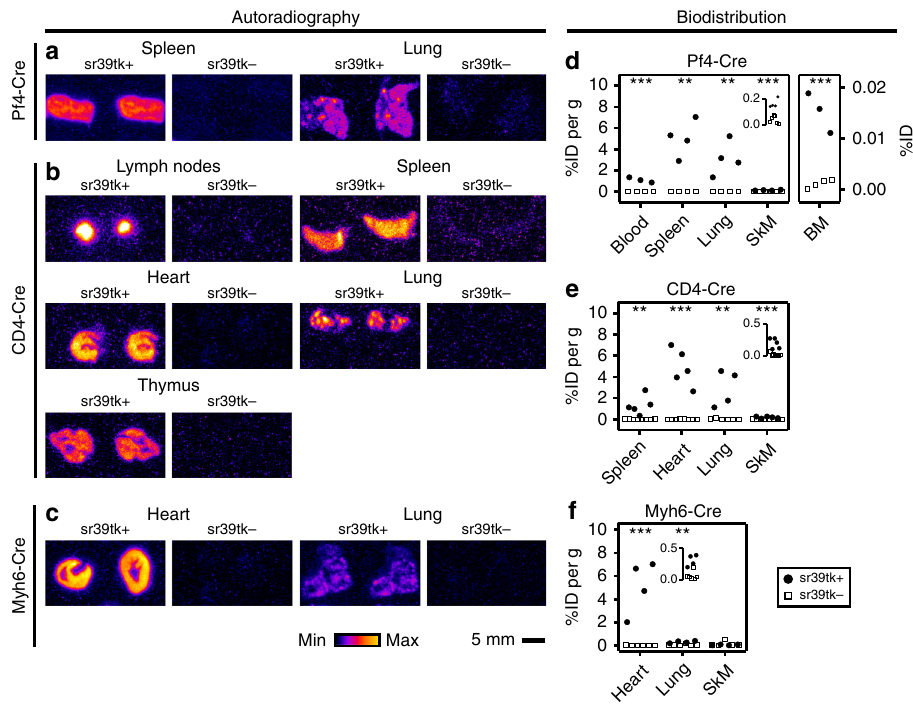
Fig. 3 Ex vivo analysis of [ 18 F]FHBG uptake in mice with different sr39tk expression pro fi les. a – c Representative [ 18 F]FHBG autoradiographs from various organs of ( a ) Pf4/sr39tk (Pf4-Cre), ( b ) CD4/sr39tk (CD4-Cre) and ( c ) Myh6/sr39tk (Myh6-Cre) mice. sr39tk-expressing mice (sr39tk+; genotype: Cre[tg/+],R26[sr39tk/+]) were compared with Cre-negative control mice (sr39tk − ; genotype: Cre[+/+],R26[sr39tk/+]); ‘ + ’ denotes the wild-type allele. Twenty-micrometer cryosections were used except for lymph nodes ( b ), which were not cut before autoradiography. Autoradiographs of the same organs from sr39tk+ and sr39tk − mice were derived from the same phosphor screen, but they were not normalized between organs or Cre lines. Organs were not cleared from blood before analysis. Similar results were obtained with organs from ≥ 3 animals of each genotype. d – f Biodistribution analysis of [ 18 F]FHBG uptake into organs isolated from ( d ) Pf4/sr39tk (Pf4-Cre), ( e ) CD4/sr39tk (CD4-Cre) and ( f ) Myh6/sr39tk (Myh6-Cre) mice with (sr39tk+, black symbols ) or without (sr39tk − , open symbols ) expression of sr39tk. Uptake was normalized to injected tracer dose (ID) and tissue weight, except for bone marrow (BM, d ), which was fl ushed from one tibia and femur per mouse with 1 mL PBS. Data points represent individual animals. Inset for skeletal muscle in d shows uptake between 0 and 0.2 %ID per g tissue and insets for skeletal muscle in e and lung in f show [ 18 F]FHBG uptake between 0 and 0.5 %ID per g tissue. One-way ANOVA was used to compare [ 18 F]FHBG uptake into organs of sr39tk+ and sr39tk − animals (** p < 0.01 and *** p < 0.001, respectively). Organs were not cleared from blood before analysis. BM, bone marrow; SkM, skeletal